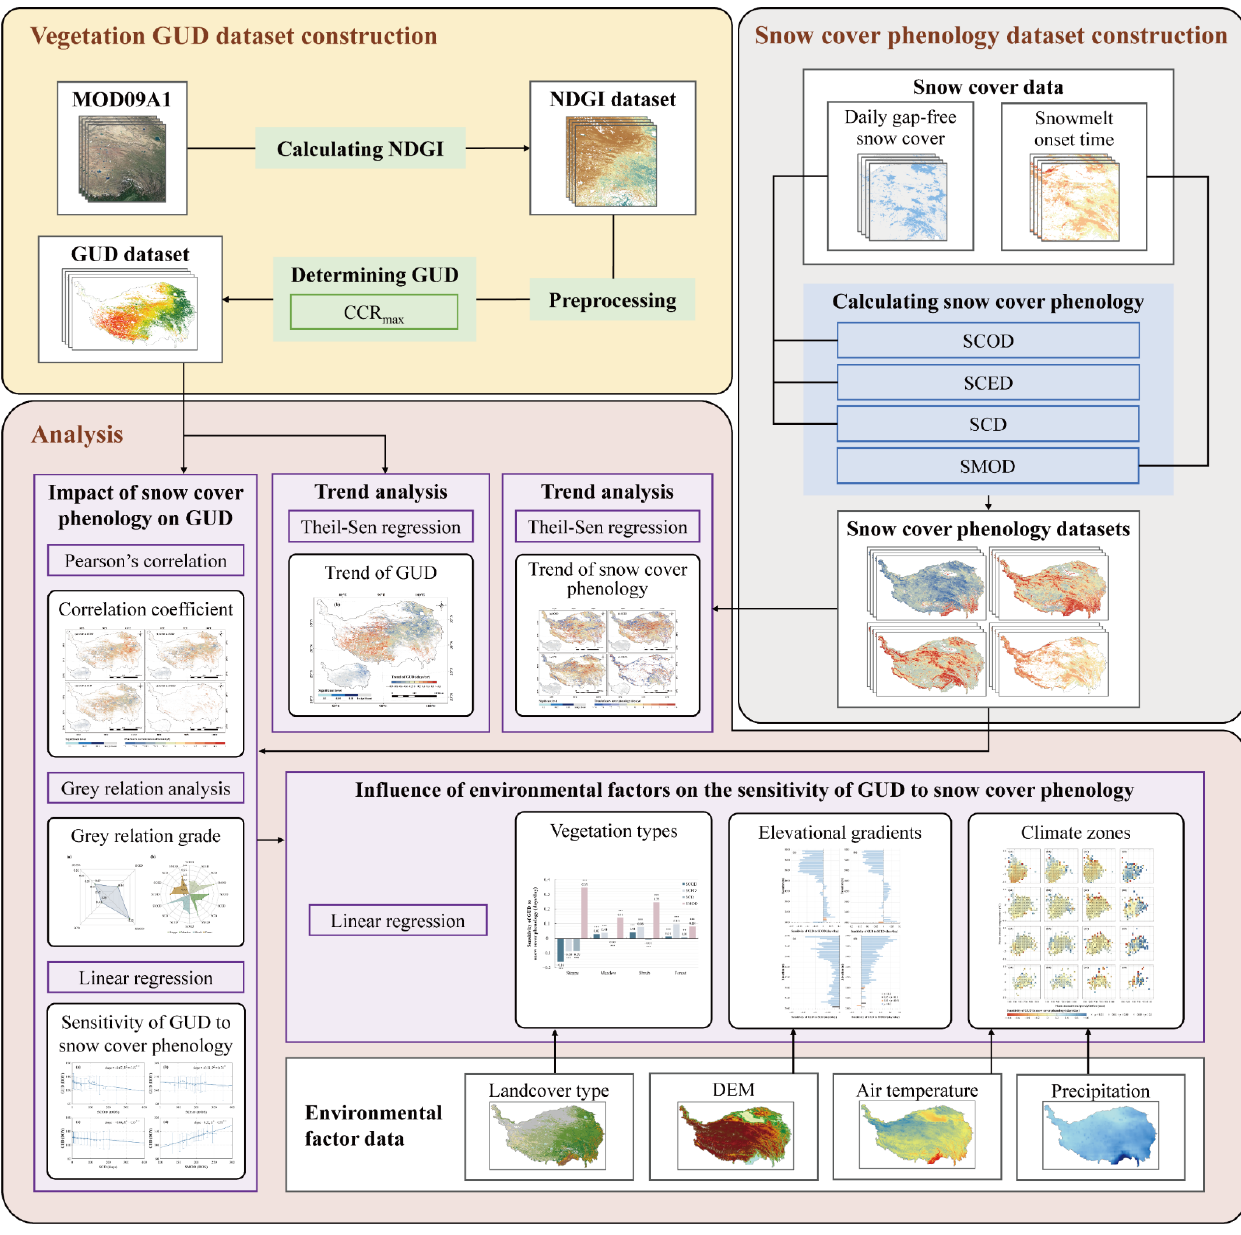
Figure 2. Flowchart for analyzing the impact of the snow cover phenology on the vegetation GUD.